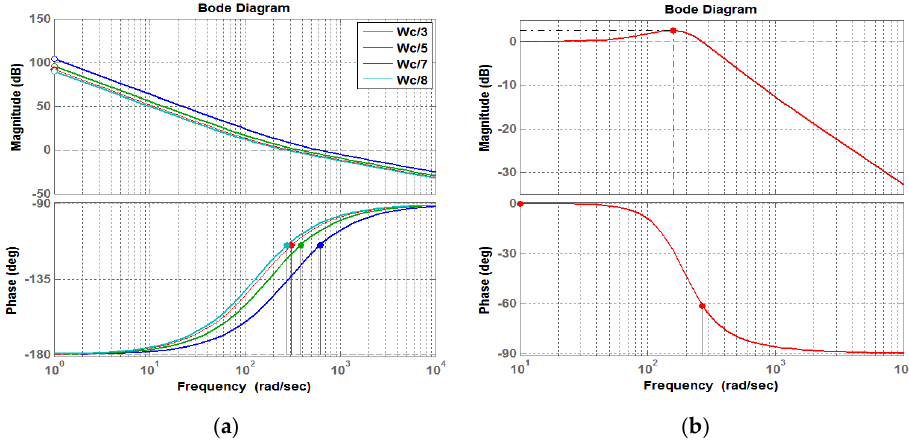
(𝑠) at the obtained K p and ( s ) at the obtained K p and 𝑑𝑐 V dc